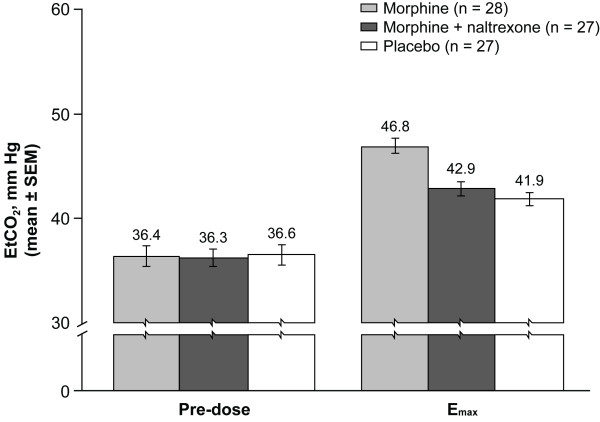
Mean pre-dose EtCO2 and post-dose Emax EtCO2 (mm Hg)(PD population). Error bars represent SEMs.